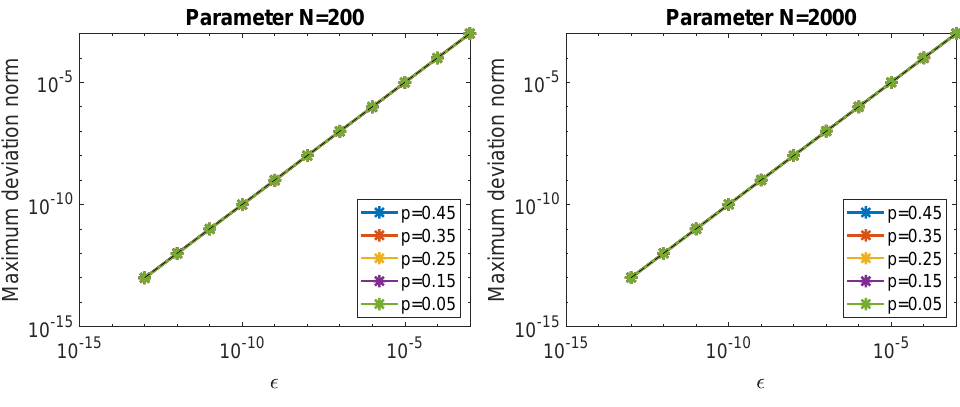
Figure 4. Maximum deviation from norm for two different segment sizes and various values of p as a function of the allowed